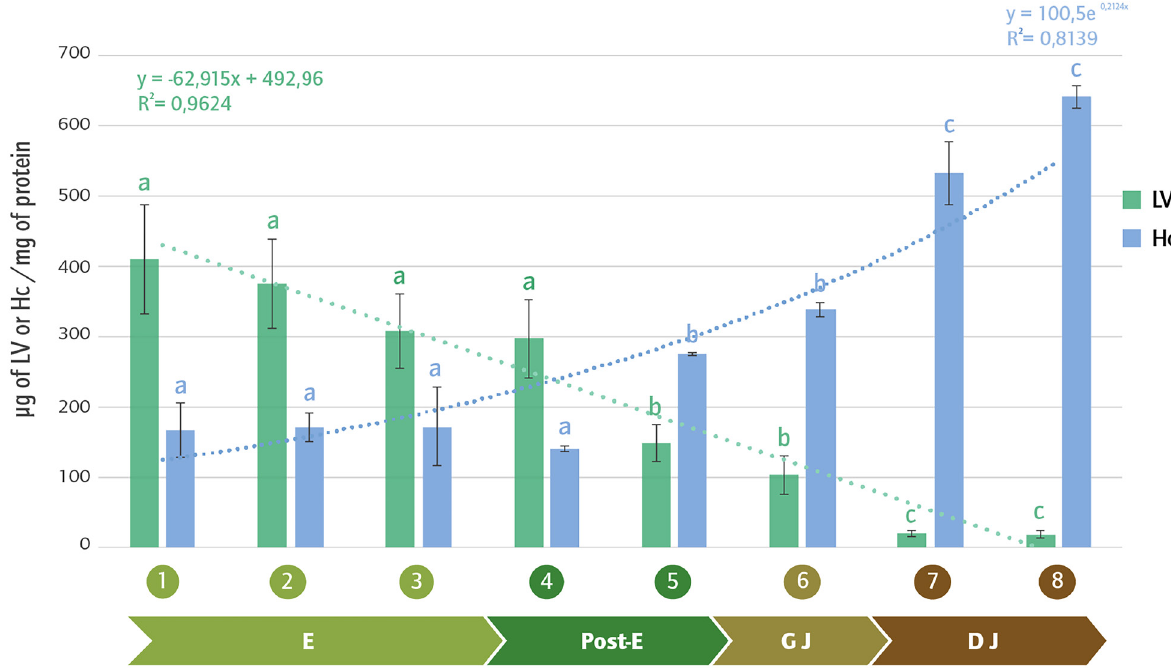
Figure 5. Analysis of lipovitellin (LV) and hemocyanin (Hc) concentration during P. pythagoricus development . Values are the means ± SDs. Different letters above the bars indicate significant differences among the different stages at p < 0.05, as determined by Tukey’s post hoc test. 1 to 8: stages of P. pythagoricus development; E: embryonic period; Post-E: post-embryonic period; GJ: juveniles in gregarious stage; DJ: juveniles in dispersal